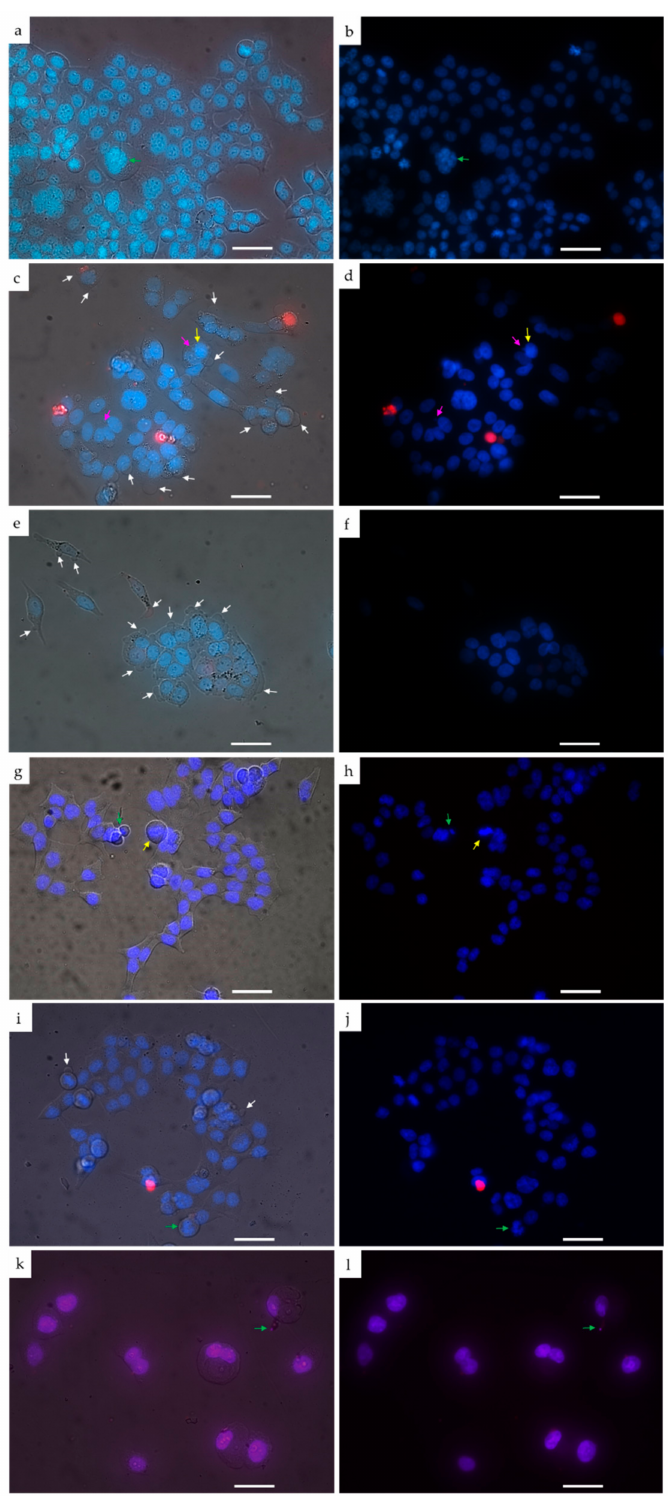
Figure 10. The images of HCT116 cells treated for 48 h with the compounds under study: ( a , b ) control; ( c , d ) MI-1 compound (1 µ g/mL); ( e , f ) MI-1/M5 complex (1 µ g/mL); ( g , h ) free M5 polymer (1 µ g/mL); ( i , j ) DMSO (1 µ g/mL); ( k , l ) doxorubicin (0.25 µ g/mL). Left –differential interference contrast (DIC) images of treated cells stained with Hoechst-33342 and Propidium iodide. Right –fluorescent image of treated cells (blue color–staining with Hoechst-33342, red–staining with Propidium iodide). Yellow arrows indicate chromatin condensation, green arrows–chromatin fragmentation, white arrows– plasma membrane blebbing, pink arrows–micronuclei). Scale 20 µ